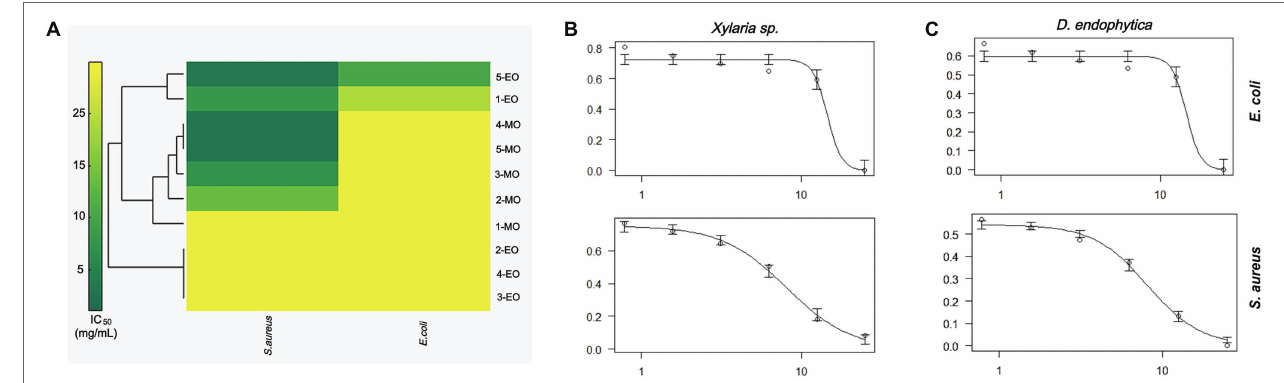
FIGURE 5 | Antibacterial activity primary screening of endophytic strains of Otoba gracilipes (A) Hierarchical cluster analysis (HCA) of half-maximum inhibitory concentration (IC 50 ) values for extracellular crude extracts (ECEs) obtained from the five fungal endophytes cultures against the evaluated pathogens. Dose-response curves were obtained for the ECEs of (B) Xylaria sp. and (C) D. endophytica against both pathogens, where the y -axis represents normalized response (0–1), while the x -axis represents extract concentration in mg/ml.